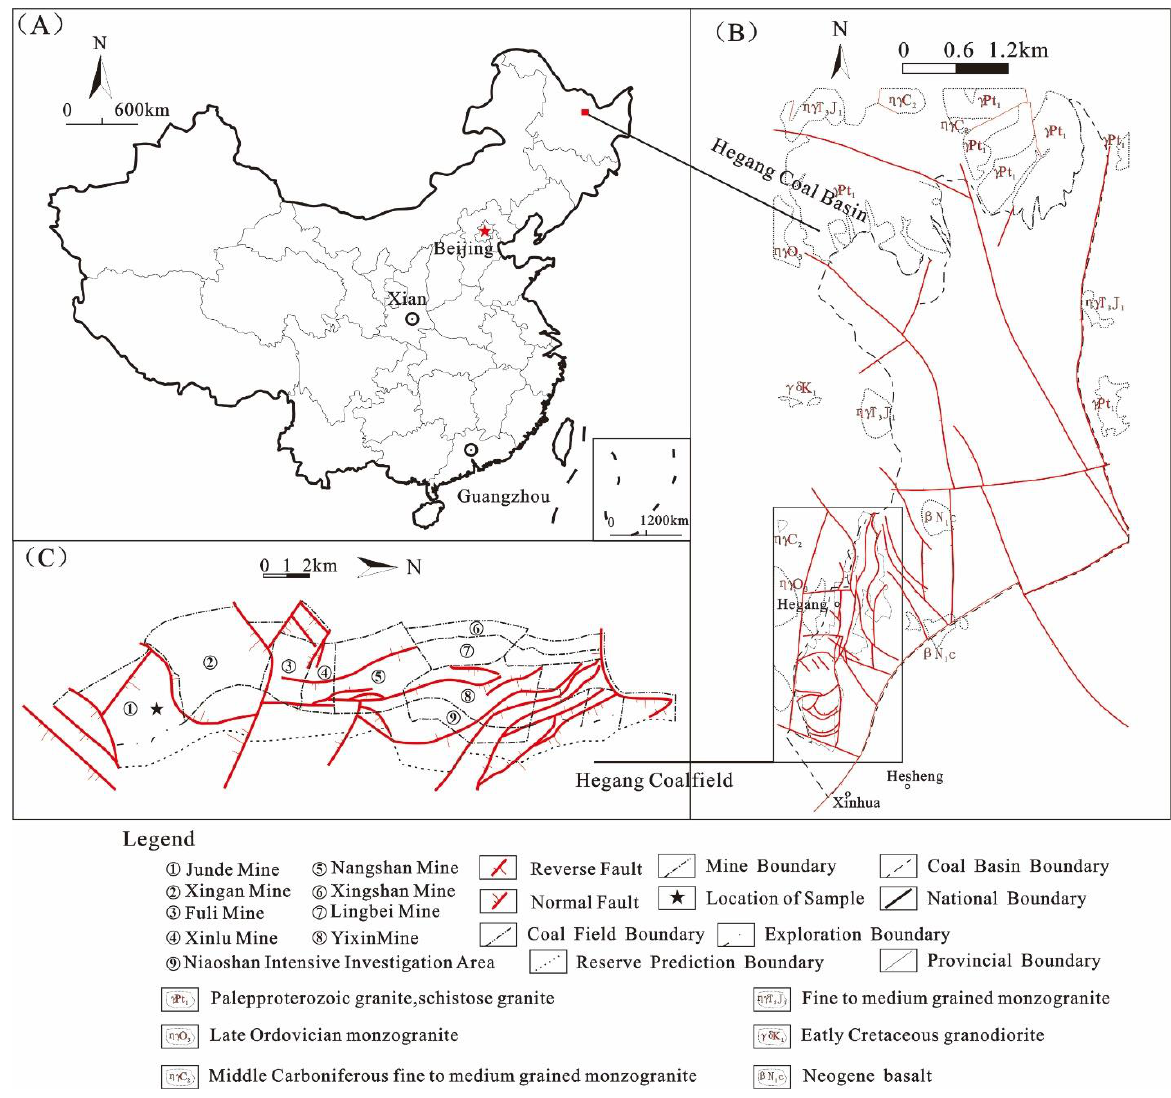
Figure 1. ( A , B ) Site of the Hegang coalfield. ( C ) Location of the Junde mine. The major coal-bearing formation in the Hegang coalfield is the Lower Cretaceous Chengzihe Formation. The Lower Cretaceous Chengzihe Formation consists of gray- white conglomerate, coarse and fine sandstone, gray-yellow medium sandstone, dark gray siltstone, mudstone, coal seams, and tuff. In Hegang coalfield, 36 coal seams are minable